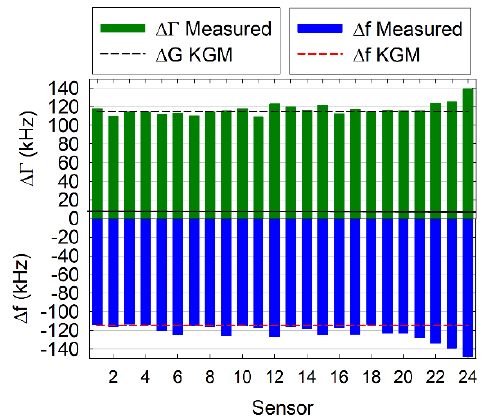
Figure 2. Air-buffer measurements. A plot of the typical set of air-to-buffer shifts for all the elements of one array (bars) with the expected values calculated based on the Kanazawa-Gordon-Mason equation (dashed lines).